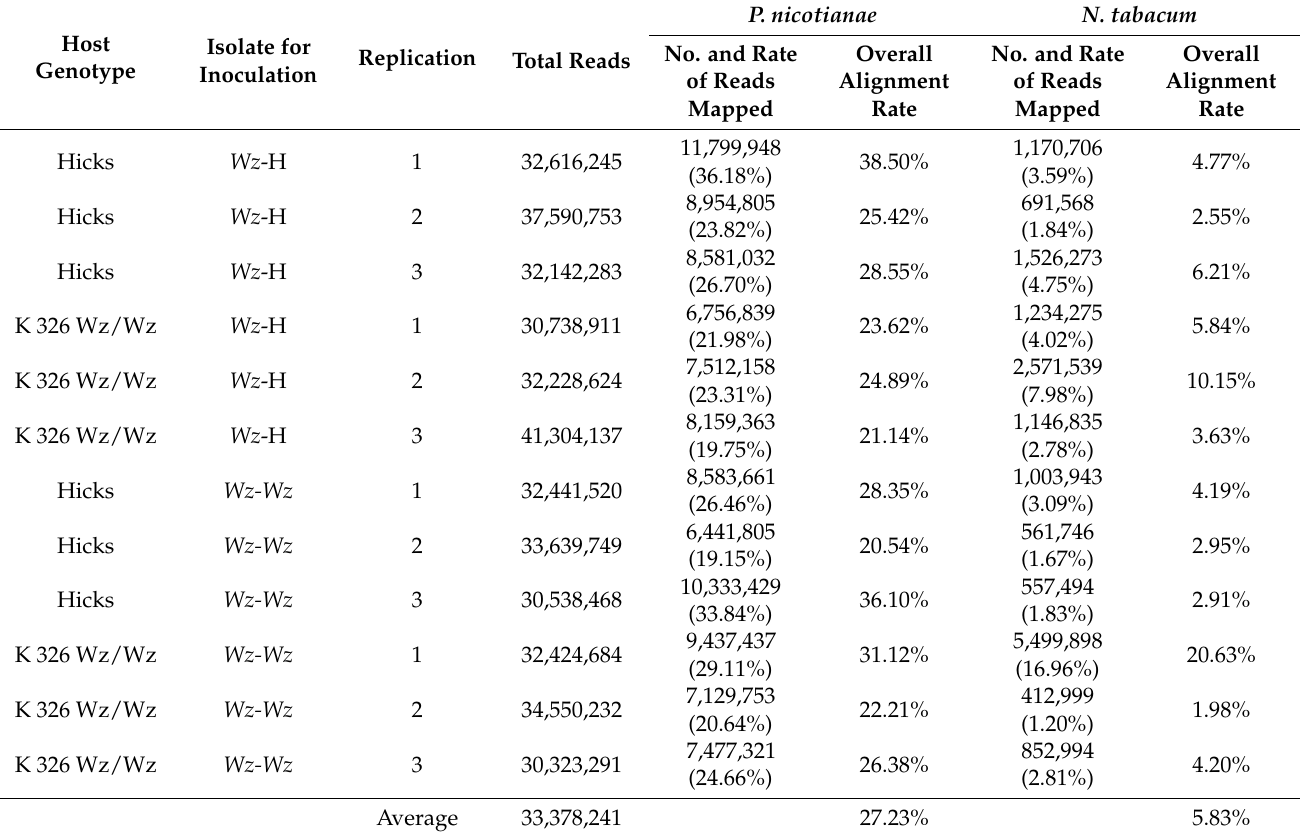
Table 2. Summary of RNAseq data and mapping